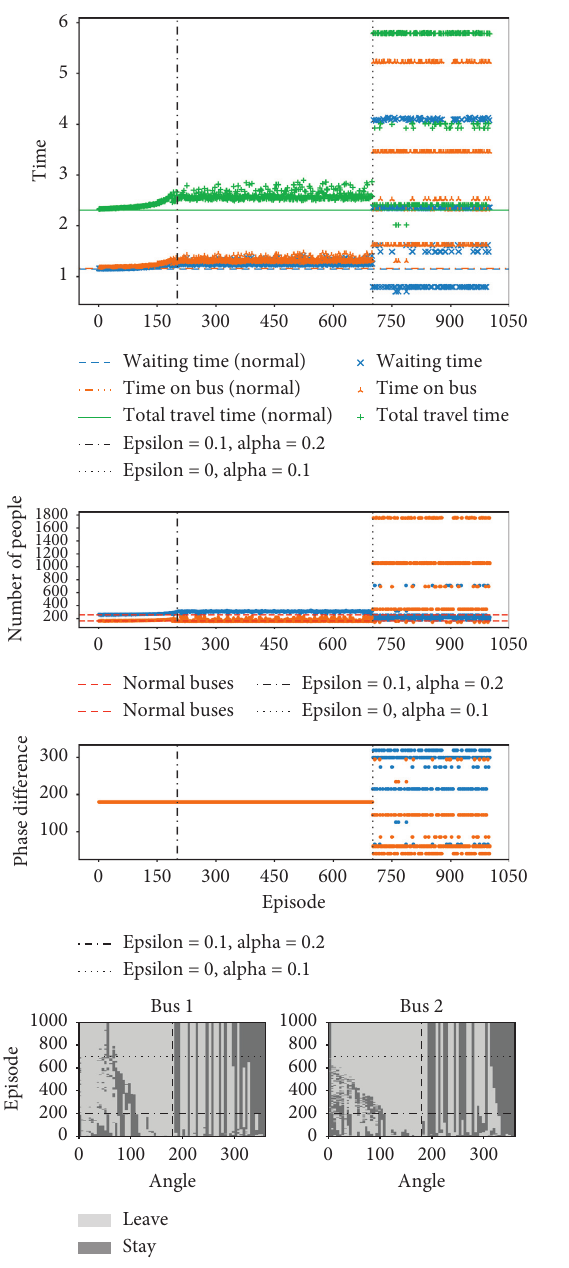
Figure 7: Two buses with frequency detuning serving a loop of bus stops during a busy period learn the holding strategy by rein- forcement learning. The entire system is slowed down greatly and generally performs worse than normal